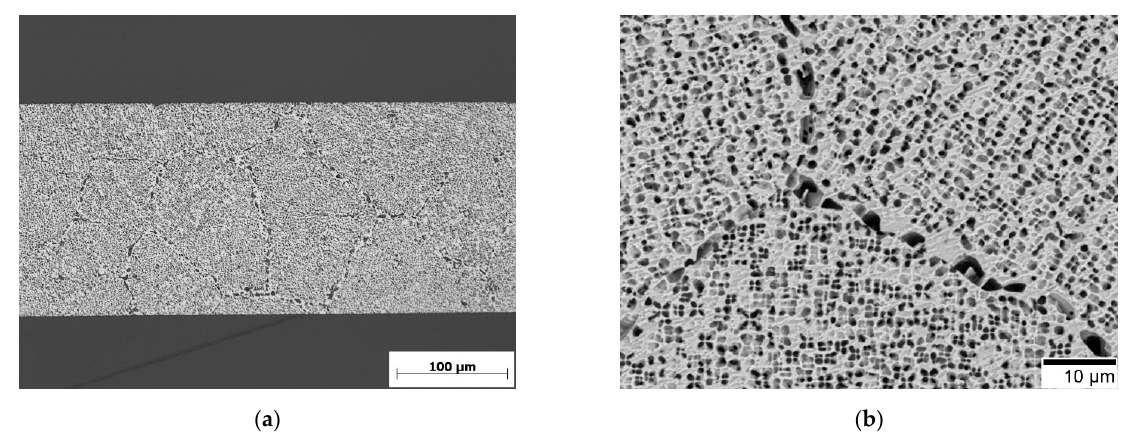
Figure 6. ( a ) Cross-section of the membrane in which the remaining γ matrix is white and the pores are black. ( b ) Grain boundary area on the surface of a tensile specimen (SEM with back scatter electron detector (BSE)).